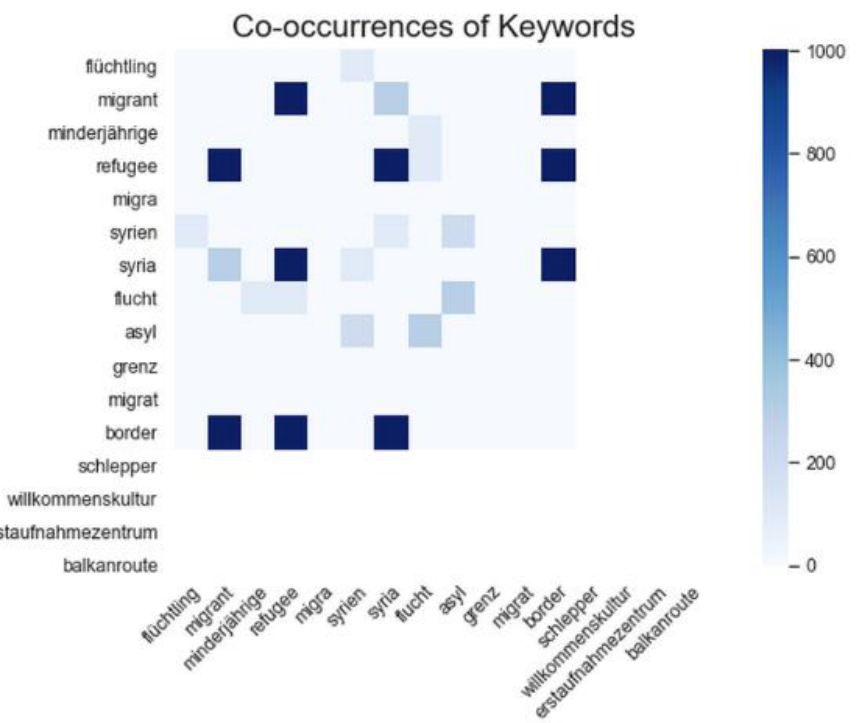
Figure 9. Absolute frequencies of German and English keyword co-occurrences in the dataset. The diagonal is set to zero to allow for better colour scaling.